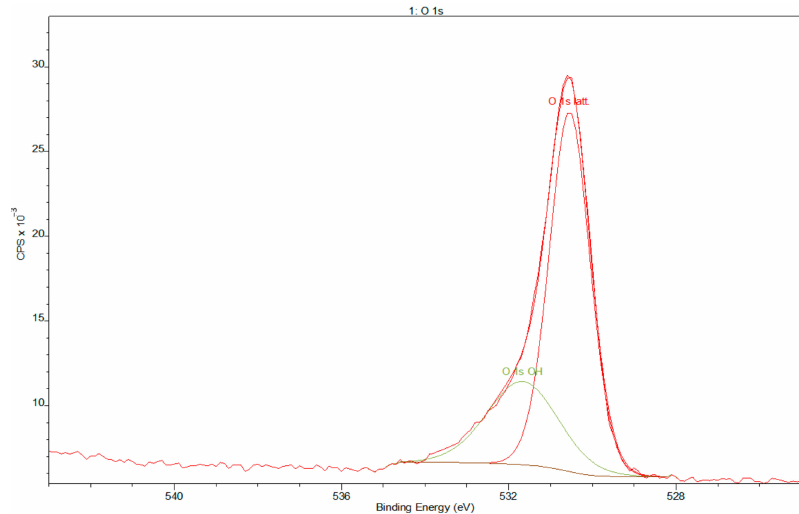
Figure 4. Deconvolution XPS spectra of oxygen.